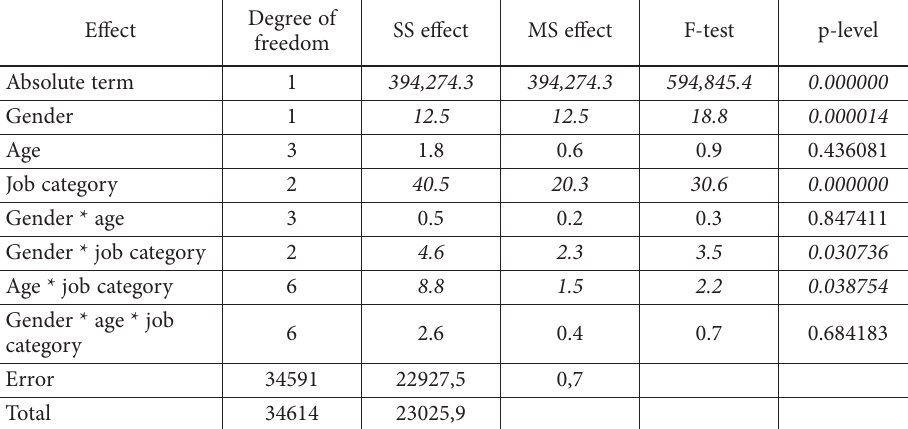
Table 7 of the one-dimensional results of the motivation factor fair appraisal system deter- mines statistically significant differences cause especially by the age and job position, gender and job position respectively. Table 7. One-dimensional results of the motivation factor fair appraisal